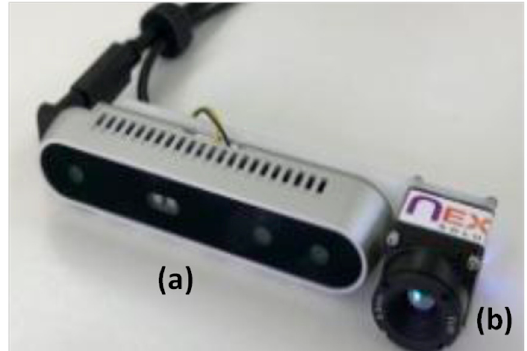
Figure 2. Imaging acquisition system: ( a ) depth visible camera and ( b ) thermal camera.